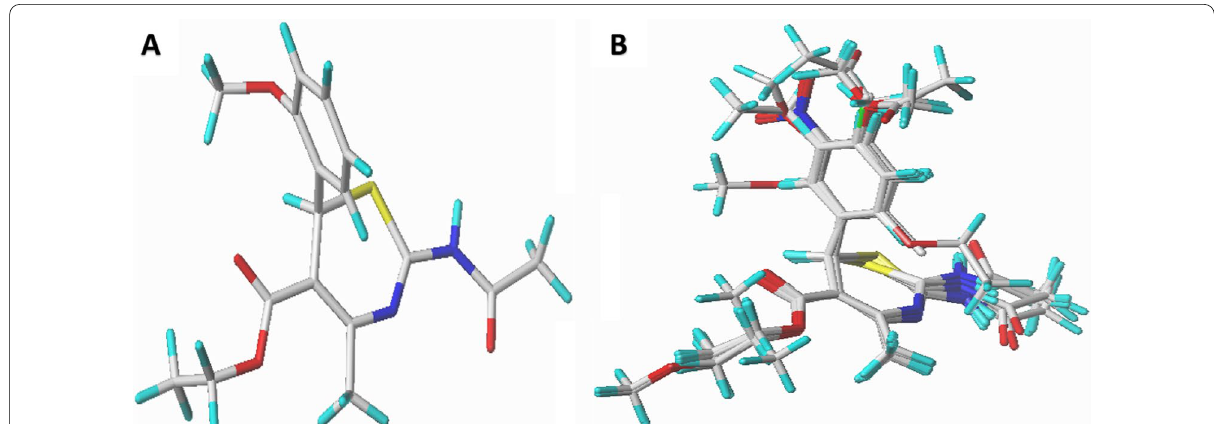
Fig. 1 Optimized structures ( A ) structure of compound 4, ( B ) alignment and superposition of the dataset compounds (capped sticks